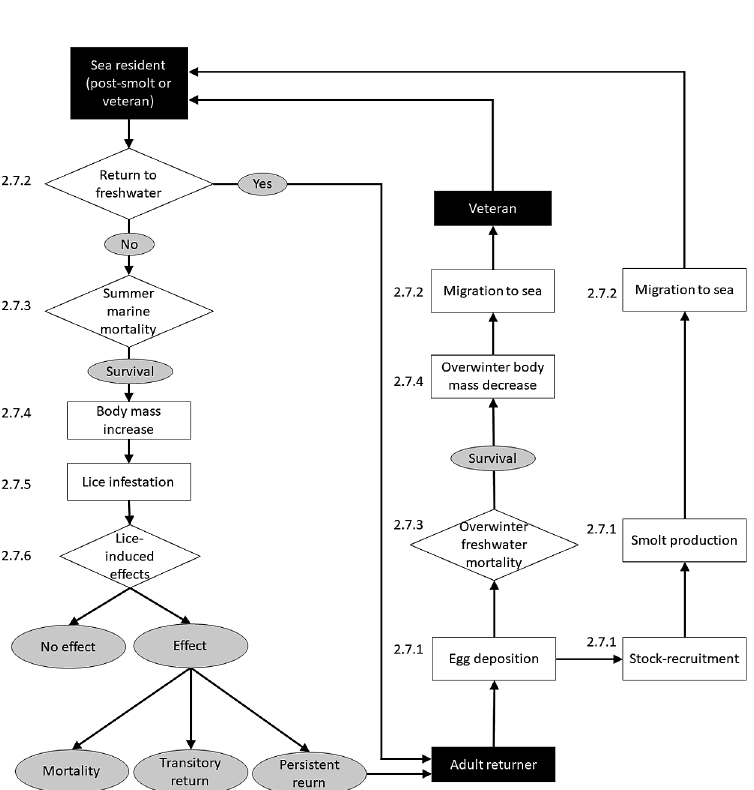
Fig. 1. IBTRUTTA individual-based model configuration. Numbers beside each function refer to submodel descriptions in the corresponding sections of text